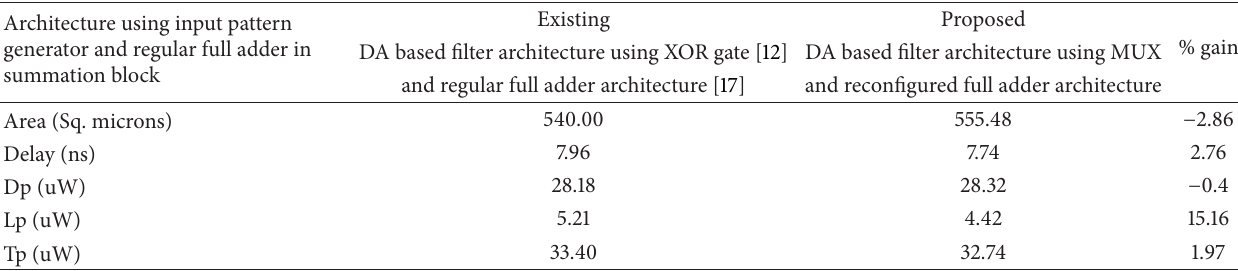
Table 3: Existing and proposed auditory filter architectures for cochlea